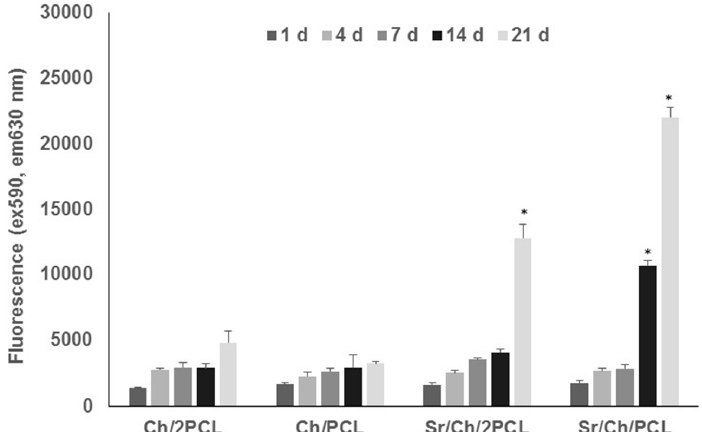
Figure 6. Alamar Blue results for blank and Sr(II) membranes in MG-63 cells over a period of 21 days. Results are given as mean ± sd ( n = 5). Asterisks (*) indicate a significant difference comparing the corresponding Sr(II) and blank groups at the same time (* p < 0.05). Ch: chitosan; PCL: poly( ε - caprolactone).